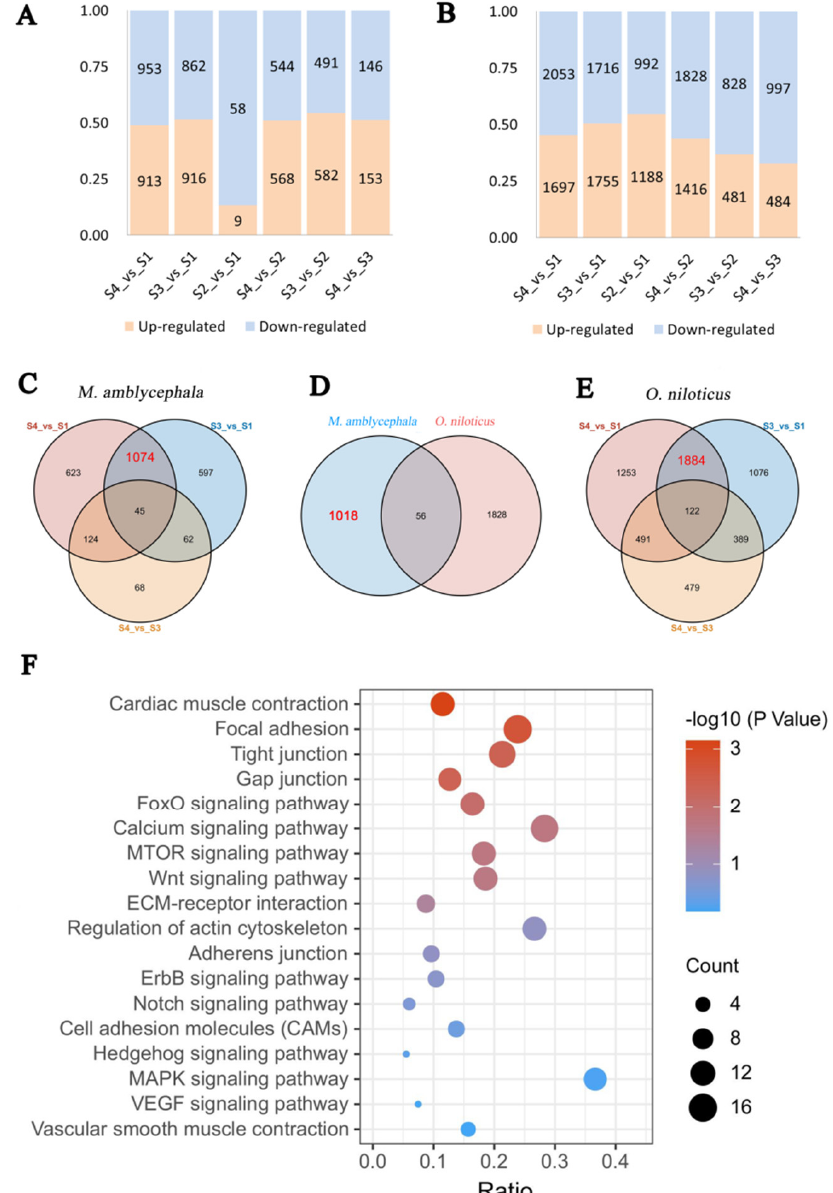
Figure 4. Comparative transcriptome analysis. ( A ) Number of DEGs in M. amblycephala ; ( B ) number of DEGs in O. niloticus ; ( C ) Venn diagram for DEGs in three comparison groups in M. amblycephala ; ( D ) Venn diagram of shared and unique genes between M. amblycephala and O. niloticus ; ( E ) Venn diagram for DEGs in three comparison groups in O. niloticus ; ( F ) signaling pathways related to bone development enriched in 1018 DEGs identified by comparative transcriptome analysis.